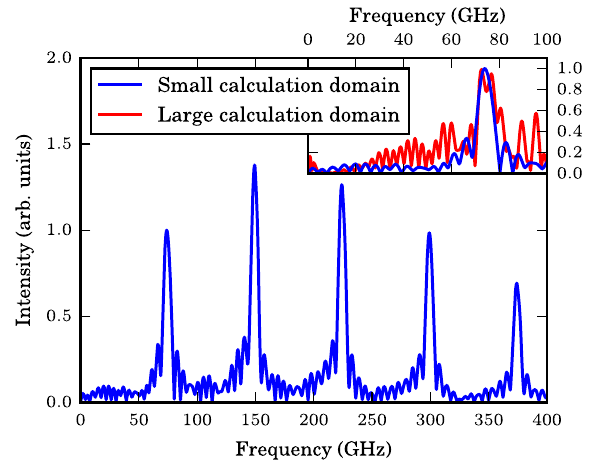
FIG. 7. Calculated SPR spectrum in small calculation domain. Inset: comparison with SPR spectrum calculated in large calcu- lation